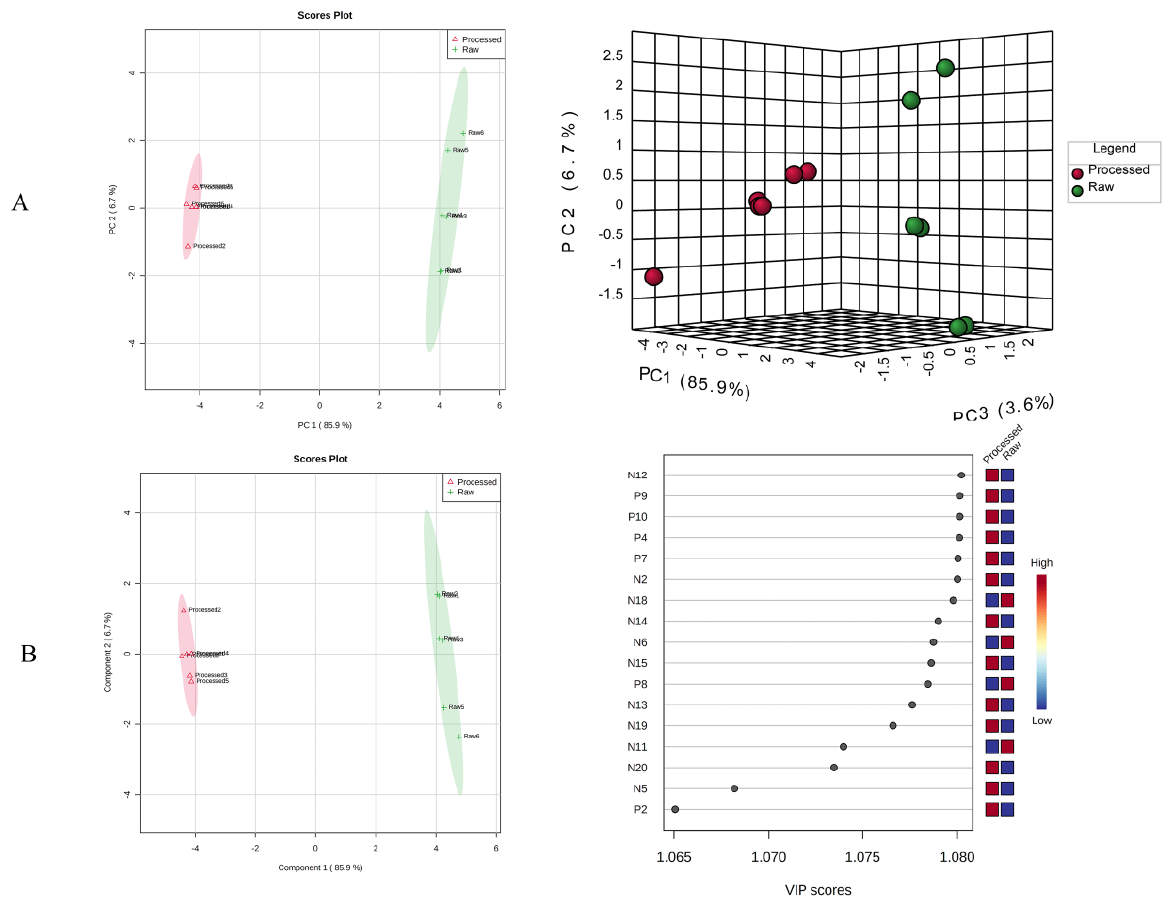
Figure 8. Multivariate statistical analysis score graph. A : PCA scores of raw and processed Sanguisorba officinalis L. (2D, 3D); B : The OPLS-DA model and VIP values of differential components in Sanguisorba officinalis L. before and after processing.